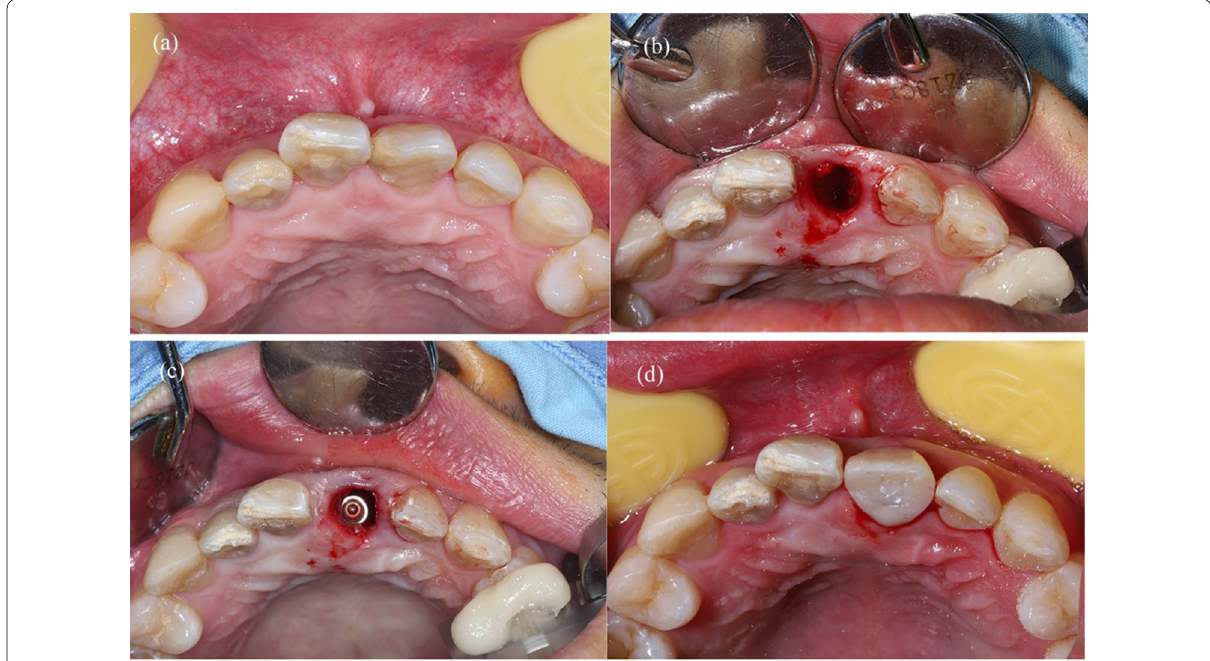
Fig. 3 Surgical procedure for the dynamic CAIS group. a Clinical observation of the hopeless tooth before surgery. b Extraction of 11. c Immediate implant placement under the fully guidance of the dynamic CAIS system. d Buccal gap was filled with bone substitute material and pre-fabricated temporary restoration was